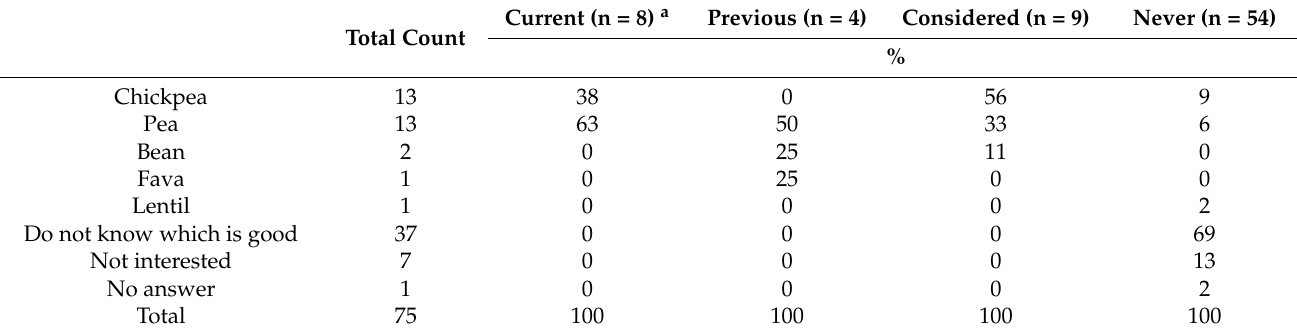
Table 2. Participants’ interest in pulse flour type by user